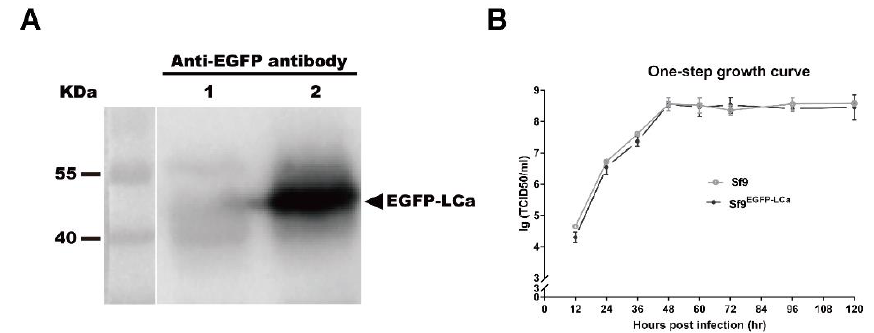
Figure 1. Construction and characterization of recombinant Autographa californica multiple nucleopolyhedrovirus (AcMNPV) and the clonal cell lines. ( A ) Western blotting analysis of cell lines Sf9 and Sf EGFP-Rab5 using an anti-EGFP antibody. An immunoreactive band of EGFP-LCa (51 kDa) was detected in the samples of Sf EGFP-LCa , but not in the sample of the negative control Sf9. ( B ) One-step growth curves of cell lines Sf9 and Sf EGFP-Rab5 . Cells were infected with vAc Pp10-EGFP at a MOI of 5. The titers of infectious budded virus were determined by TCID 50 endpoint dilution